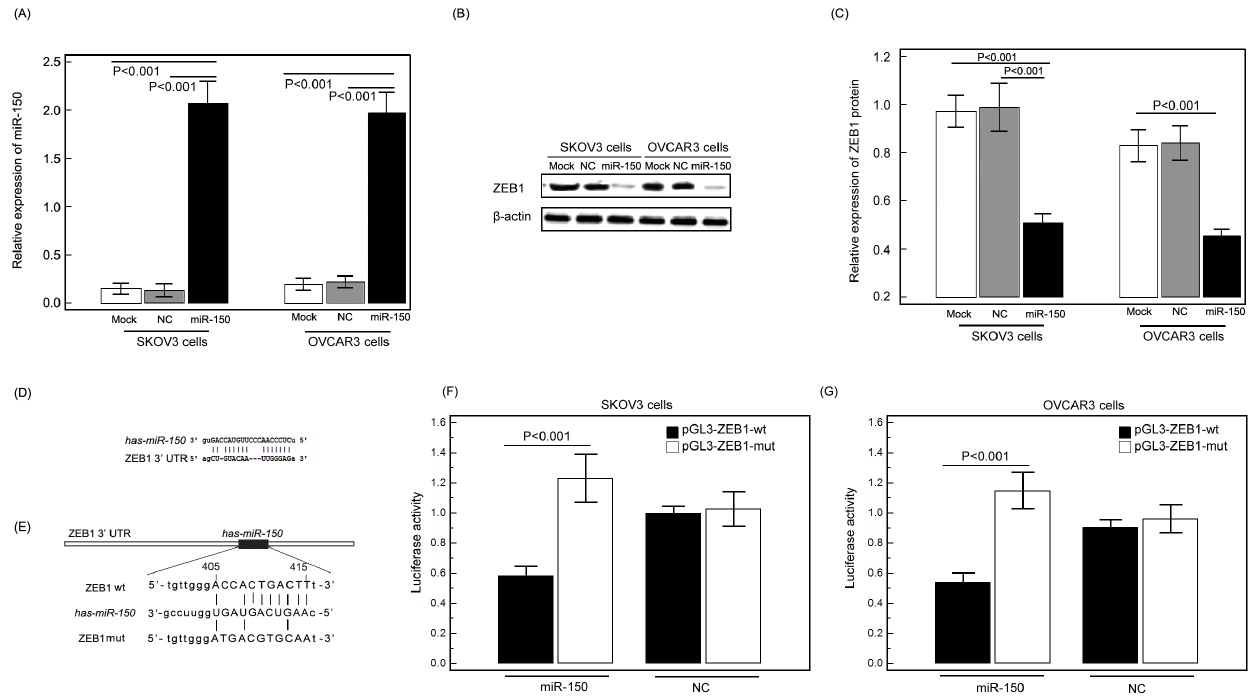
Figure 3. MicroRNA-150 (miR-150) targets Zinc Finger E-Box Binding Homeobox 1 (ZEB1) in epithelial ovarian cancer (EOC) cells. (A) Expression levels of miR-150 in SKOV3 and OVCAR3 cells by quantitative real-time PCR assay at 24 h post-transfection of miR-150 vector. (B , C) The ZEB1 protein in SKOV3 and OVCAR3 cells by western blot at 24 h post-transfection of miR-150 vector. b -actin was used as an internal loading control. ‘NC’ refers to negative control vector. (D) miR-150 binding sites in the ZEB1 3 9 -UTR. (E) RNA sequence alignment showing the 3 9 -UTR of ZEB1 mRNA contains a complementary site for the seed region of miR-150. ZEB1 mut is a mutant with substitutions in the complementary region as a negative control. (F and G) Luciferase report assay was performed to confirm the miR-150 binding target. The luciferase activity was detected after co- transfection of pGL3-ZEB1-wt or pGL3-ZEB1-mut, miR-150 vector or negative control vector (NC) into SKOV3 and OVCAR3 cells.